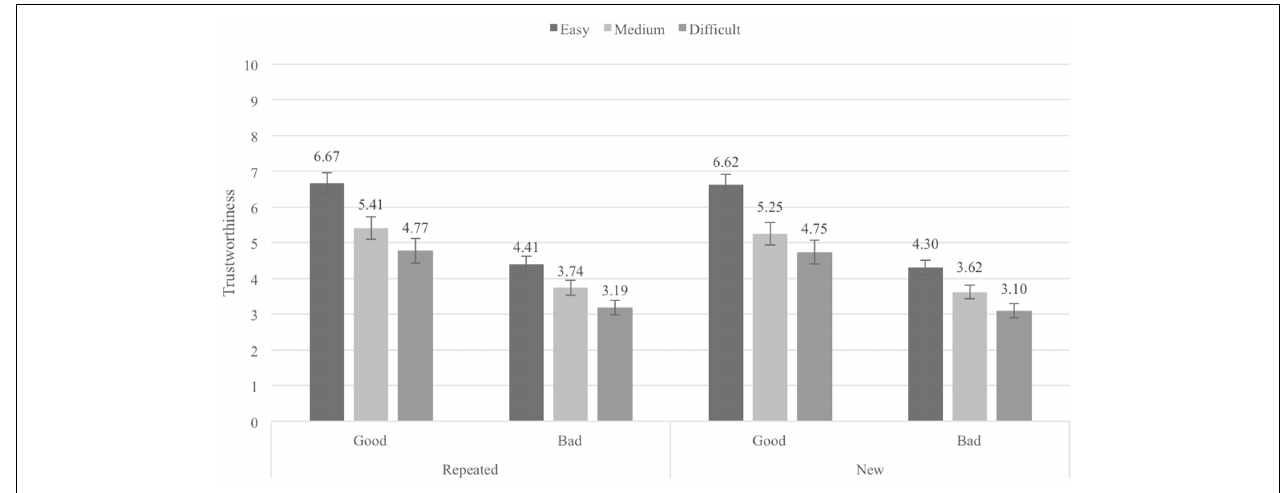
FIGURE 2 | Average trustworthiness ratings in Experiment 2, by Pronounceability, Reputation and Repetition conditions; error bars denote standard